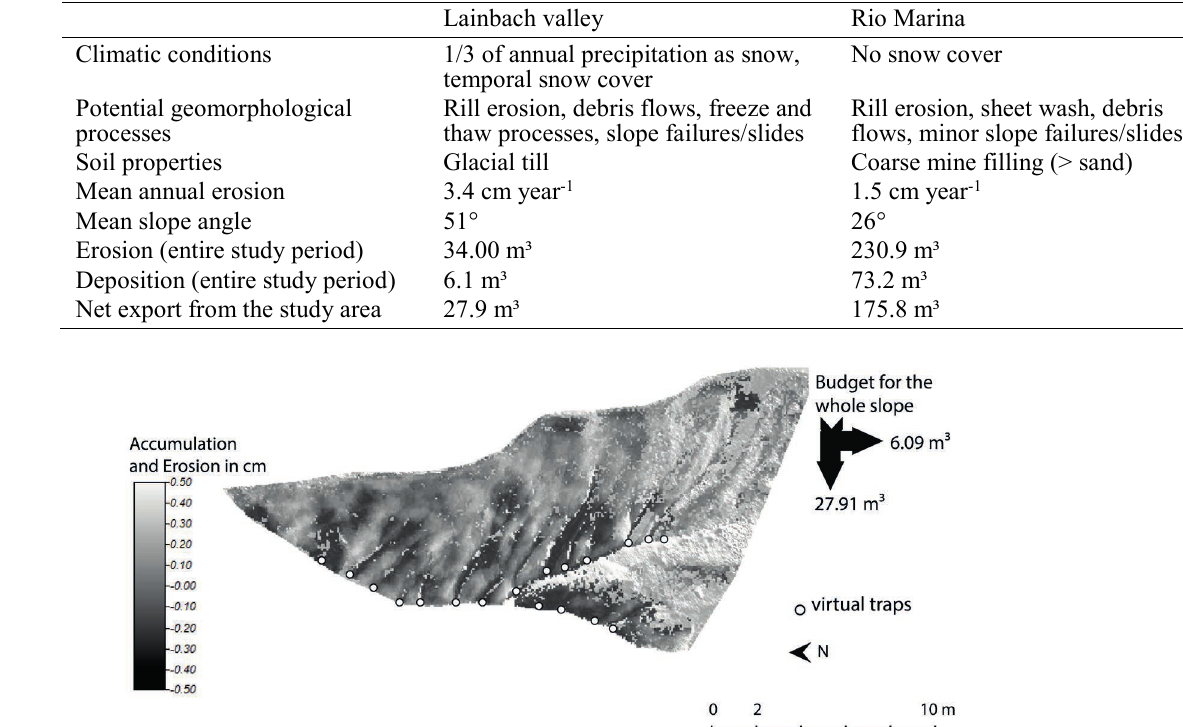
Table 2 Summary characteristics and sediment budgets for the study areas.